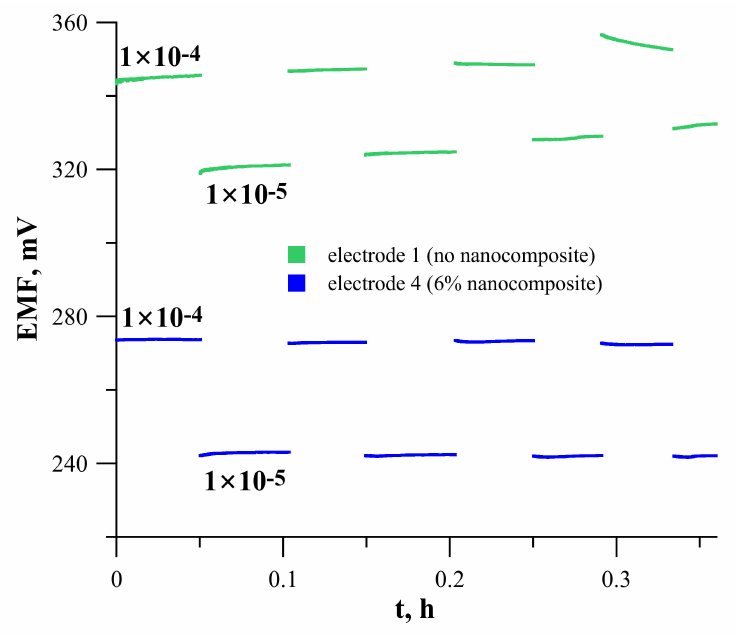
Figure 4. Potential reversibility determined in 1 × 10 − 4 and 1 × 10 − 5 mol L − 1 Cu(NO 3 ) 2